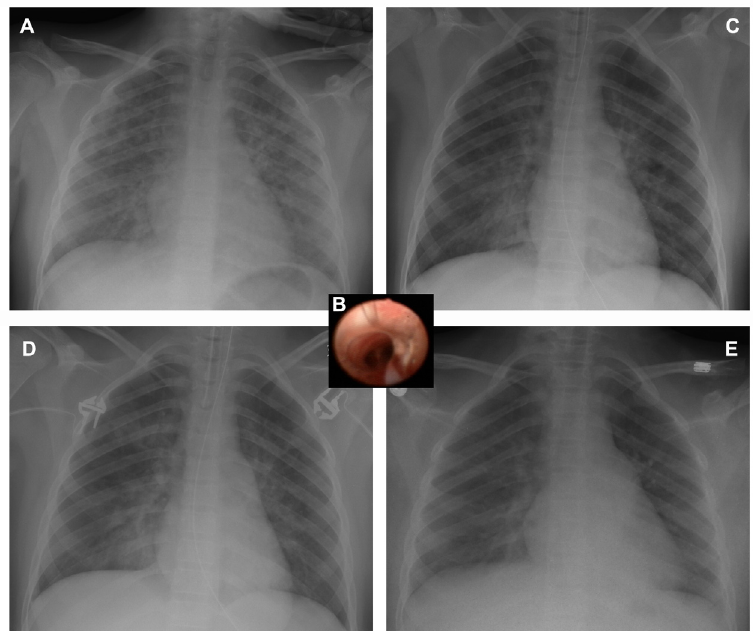
Figure 1. Chest radiographic images of a fourteen year-old patient. Onset of pulmonary edema at hour 0 (panel a ) and progress at hour 10 (panel c ), hour 17 (panel d ) and resolution of post obstructive pulmonary edema at hour 37 (panel e ). Intraoperative bronchoscopy at hour 1.5 showing pulmonary edema (panel b